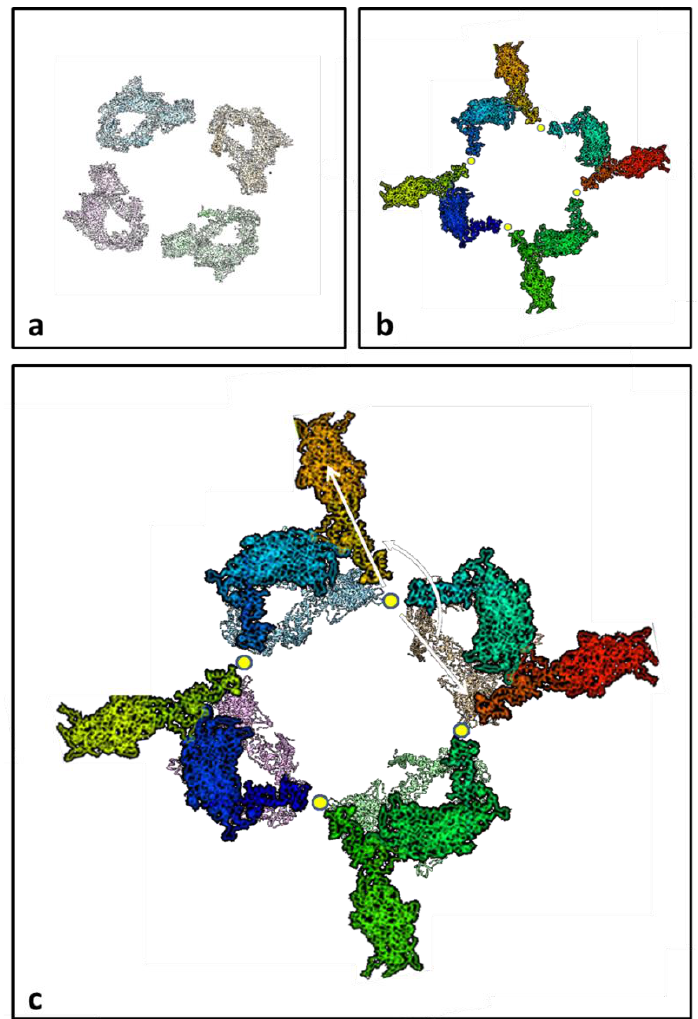
Figure 12. ( a ) One crown of the IHM (super-relaxed?) head configuration on the myosin filaments of insect flight muscle, looking M-wards and showing the interacting head motif (cf. Figure 9). ( b ) One crown of the resting insect flight muscle myosin filament (slightly refined from) reported by